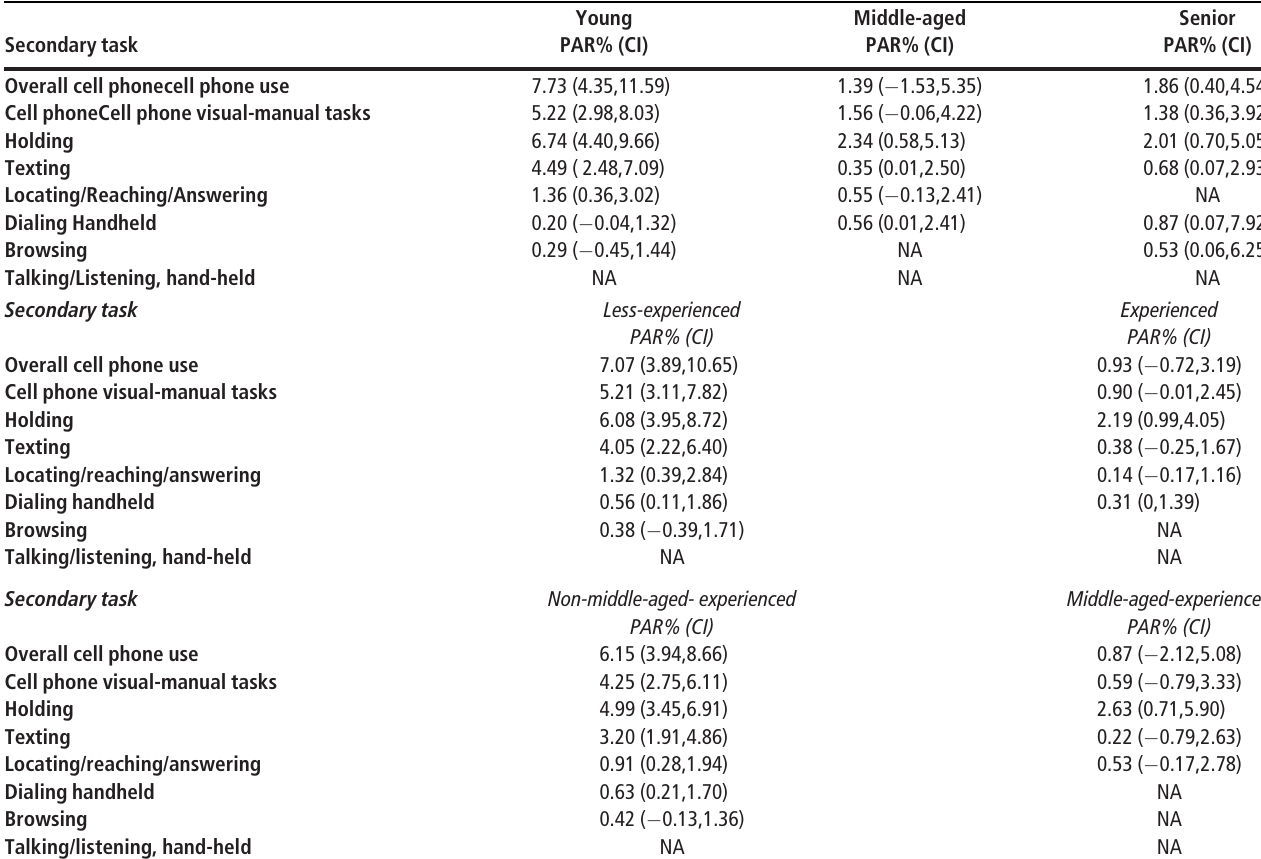
Table IV The PAR percentage (with 95% CI) of cell phone use by driver